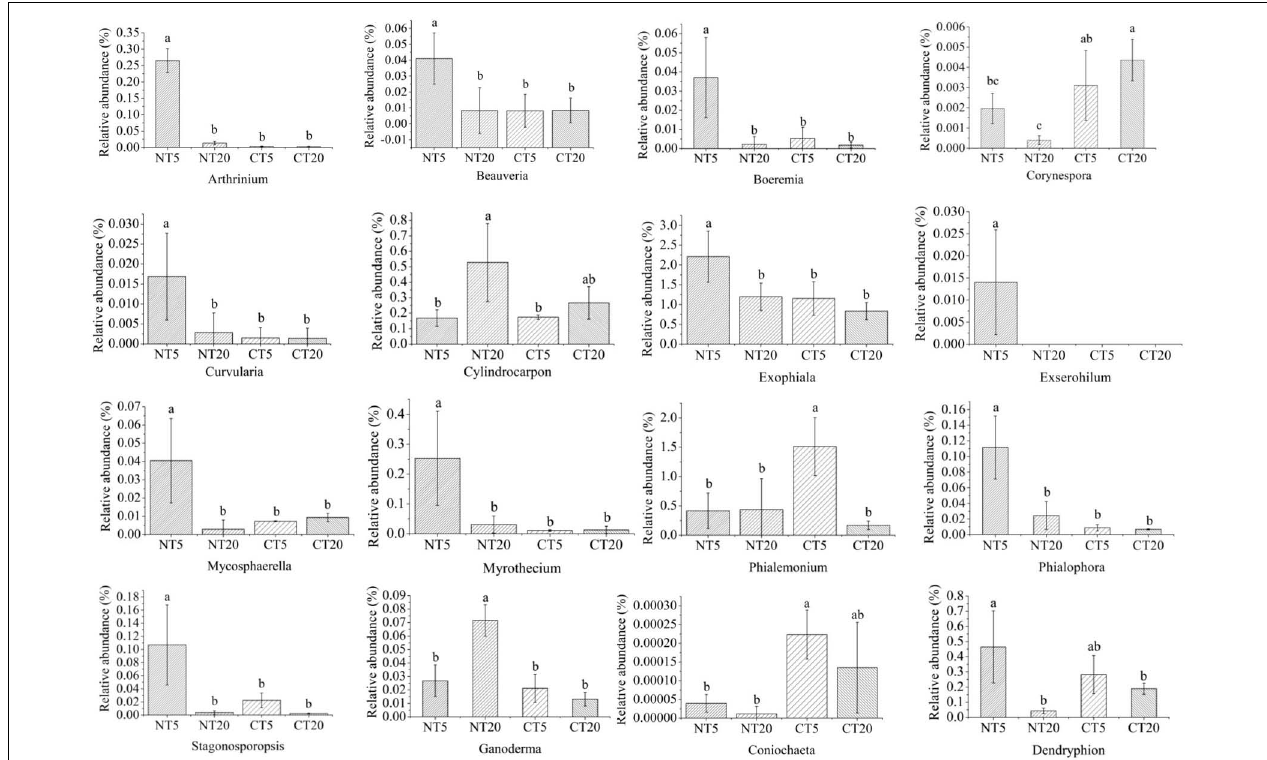
FIGURE 3 | Relative abundance of soil potential pathogens fungi under NT and CT. Different small letters indicated difference between different treatments ( P < 0.05).